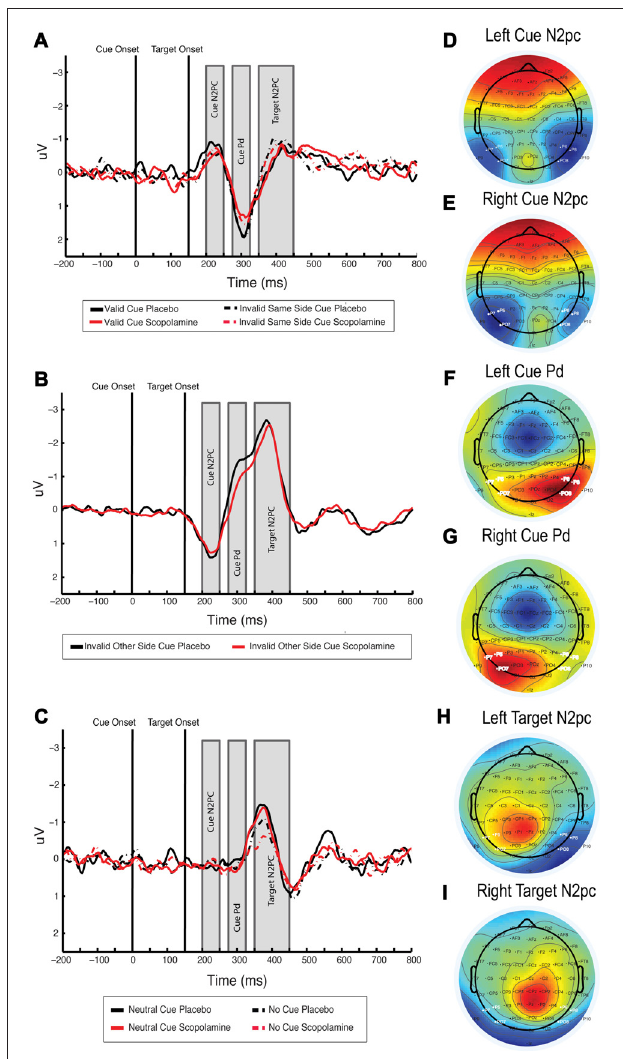
FIGURE 5 | (A) Difference waveform illustrating cue N2pc, cue Pd and target N2pc for invalid-same-side and valid cues, waveforms averaged over PO7/P7/P5 and PO8/P8/P6, respectively, for left and right and then collapsed over side. (B) Difference waveform illustrating cue N2pc, cue Pd and target N2pc for invalid-other-side cues, waveforms averaged over PO7/P7/P5 and PO8/P8/P6, respectively for left and right and then collapsed over side. Note that waveforms were calculated with respect to the target location, resulting in a positive going cue N2pc. (C) Difference waveform showing cue N2pc, cue Pd and target N2pc for neutral and no-cue conditions. Waveforms are averaged over PO7/P7/P5 and PO8/P8/P6, respectively, for left and right and then collapsed over side. (D,E) Topography of the cue-related N2pc component under placebo for left and right target-colored cues, averaged between 200 ms and 250 ms after cue onset. (F,G) Topography of the cue-related Pd component under placebo for left and right target-colored cues, averaged between 275 ms and 325 ms after cue onset. (H,I) Topography of the target-related N2pc component under placebo for left and right targets, averaged between 200 ms and 300 ms after target onset; n =